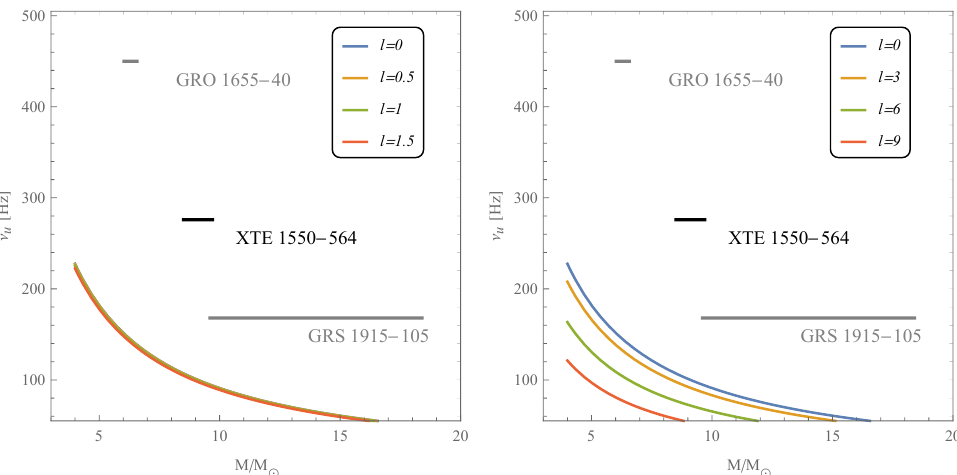
Figure 8. Fit of 3:2 frequencies ratio to mass estimate of microquasars for various parameter l by using the epicyclic resonance model. This model is used in all the following figures of fits. Values of l giving black hole are on the left panel, while values of l giving wormholes (except l = 0, which gives the Schwarzschild black hole) are on the right